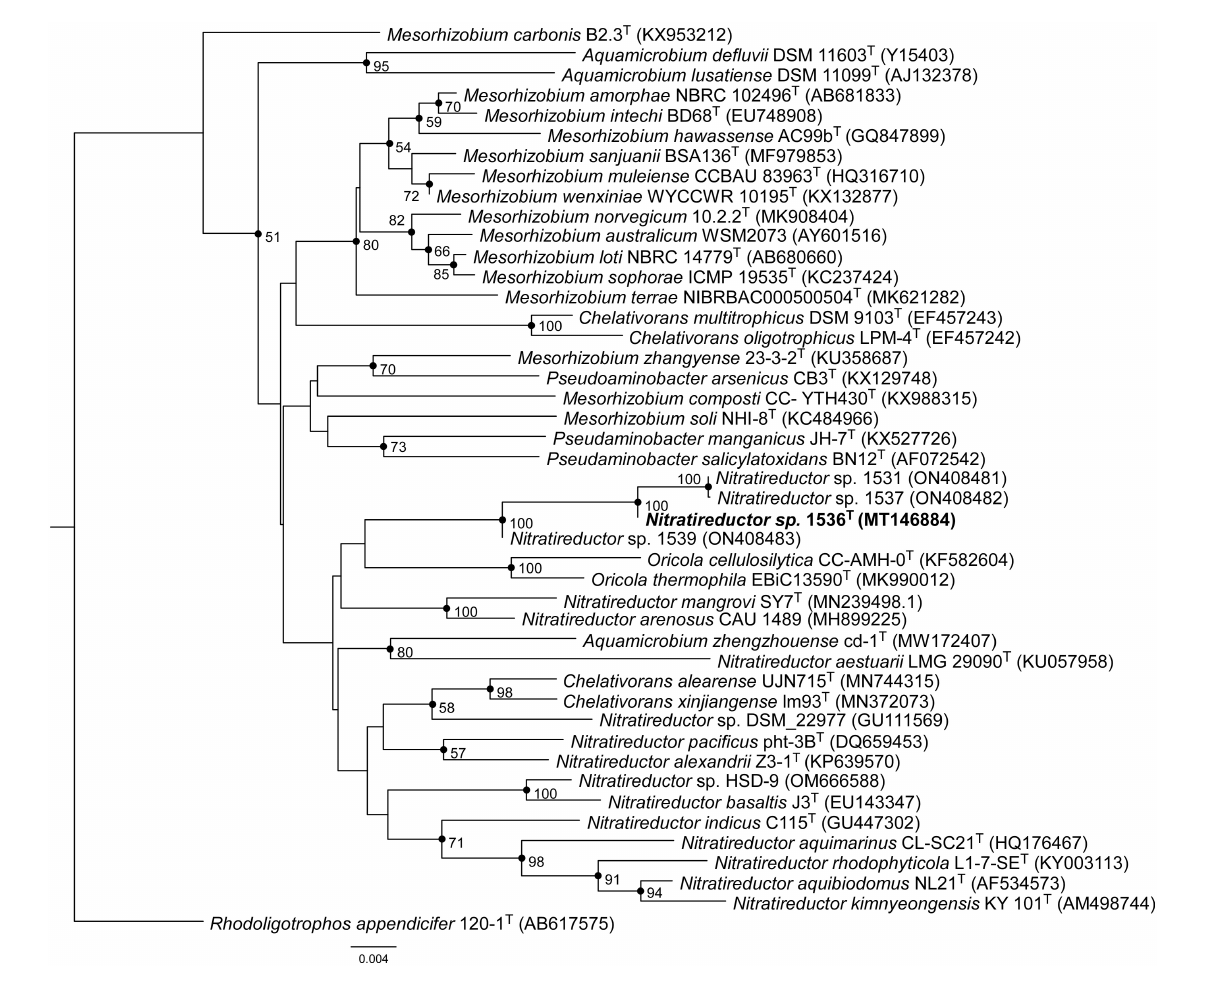
FIGURE2 Neighbor-joining phylogenetic tree based on the bacterial 16S rRNA gene sequences showing the position of Nit1536 T . Only bootstrap values (expressed as percentages of 1,000 replications) of > 50% are shown at the branching points. Filled circles indicate branches that were also recovered using the maximum-likelihood method. Rhodoligotrophos appendicifer 120-1 T (AB617575) was used as an outgroup. Bar, 0.004 substitutions per nucleotide